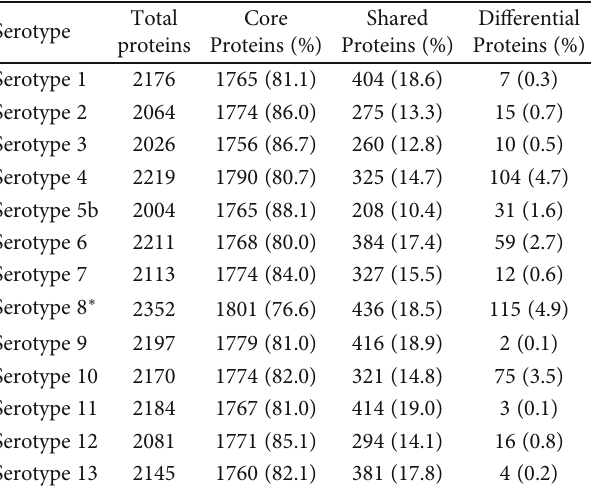
Table 3: Characterization of protein groups in di ff erent serotypes of A. pleuropneumoniae